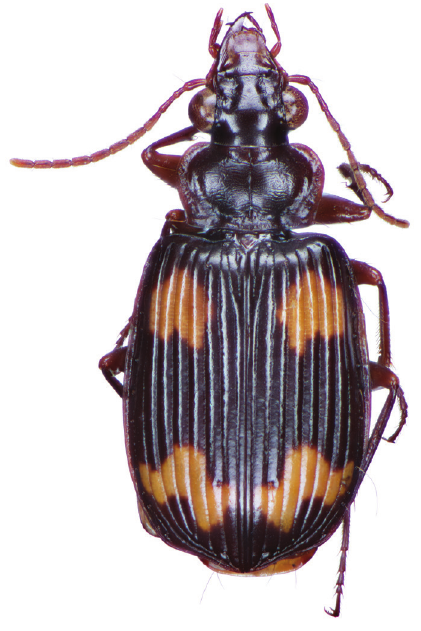
Figure 41. Dorsal habitus and color pattern of C. ( Coptoderina ) japonica Bates. (OBL 10.24 mm). interval 5 and 6, closest to apex of elytra in interval 4, posterior macula, from interval 2–8 (some from interval 1), closest to base of elytra in intervals 4 and 5, closest to apex of elytra in interval 4; margins of elytra rufo-brunneous to piceous; ventral surface rufo-brunneous to piceous; legs with trochanter and femora and tarsi brunneous to rufo-brunneous, tibia rufo-brunneous to piceous on dorsal surface. Microsculpture . Dorsum of head with microsculpture somewhat granulate and iso- diametric, easily visible at 50× magnification; pronotum somewhat granulate, isodia- metric to somewhat transverse mesh pattern easily visible at 50×; elytral intervals with transverse sculpticells, center of striae with isodiametric sculpticells a few cells wide; ventral surface of head with microsculpture transverse, faintly visible at 50×; proster- num, proepipleuron, mesepisternum and metepisternum with sculpticells forming a shallow transverse